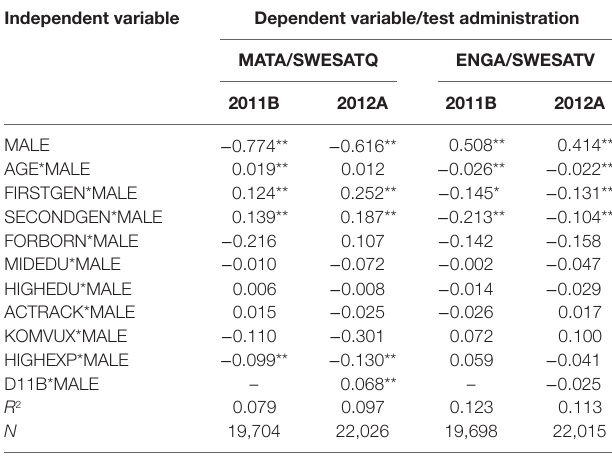
taBlE 5 | Least squares estimates of gender differences in ranking of course grades vs Swedish admissions test (SweSAT) quantitative and verbal